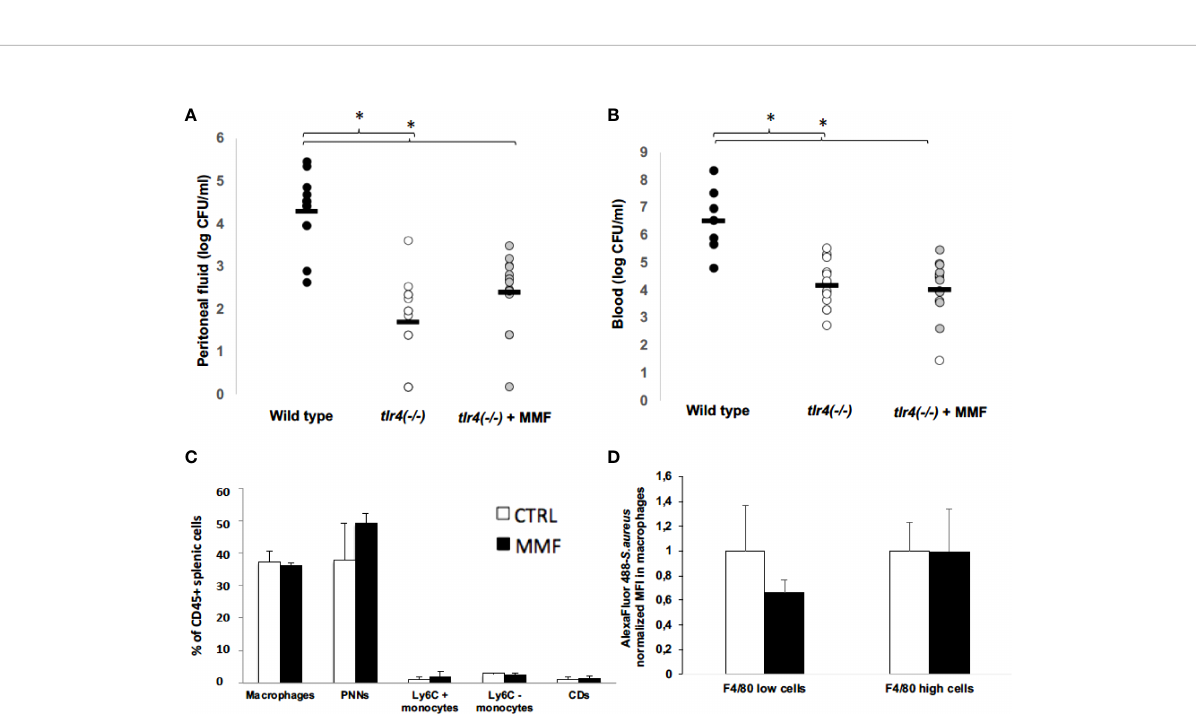
FIGURE 7 MMF has no impact on bacterial clearance, on splenic and peritoneal cells and on macrophages phagocytosis activity 24 hours after S. aureus infection in Tlr4(-/-) mice Tlr4(-/-) mice. Mice were treated with MMF, which started one day before i.p. injection of 10 8 CFU S. aureus (n=14, grey dots) and were compared to control mice treated with an equivalent volume of NaCl 0.9% (wild type, n= 12, black dots; Tlr4(-/-) control mice, n=14, white dots). At H24 after infection, mice were euthanized and quantitative bacterial culture was assessed in peritoneal fl uid (A) and blood (B) . Mice were treated i.p. with MMF (n=7, black histogram), or with the same volume of NaCl 0.9% (control mice, n=7, white histogram), which started one day before the i.p. injection of S. aureus . 24 hours after infection, splenic cells were stained for CD45, CD11b, Ly6C and Ly6G (PMNs), CD11b and Ly6C (monocytes), CD11b and F4/80 (macrophages) and CD11c (conventional dendritic cells) (C) . Peritoneal cells (6. 10 6 cells) were isolated from Tlr4 (-/-) mice treated with MMF (black histogram) or NaCl 0.9% (white histogram) for 4 days, and were incubated 30 minutes with S. aureus (MOI 10) stained with Alexa Fluor 488. Cells were then stained for the macrophage marker F4/80, and intracellular mean fl uorescence of intensity (MFI) was measured by fl ow cytometry in F4/80+ macrophages and F4/80 high macrophages. MFI for each condition was normalized on the average of MFI in control mice for each experiment. Data were representative of 2 experiments (D) . Differences between MMF and control conditions were calculated using ANOVA with Tukey ’ s multiple comparisons tests and Student ’ s t test. * P